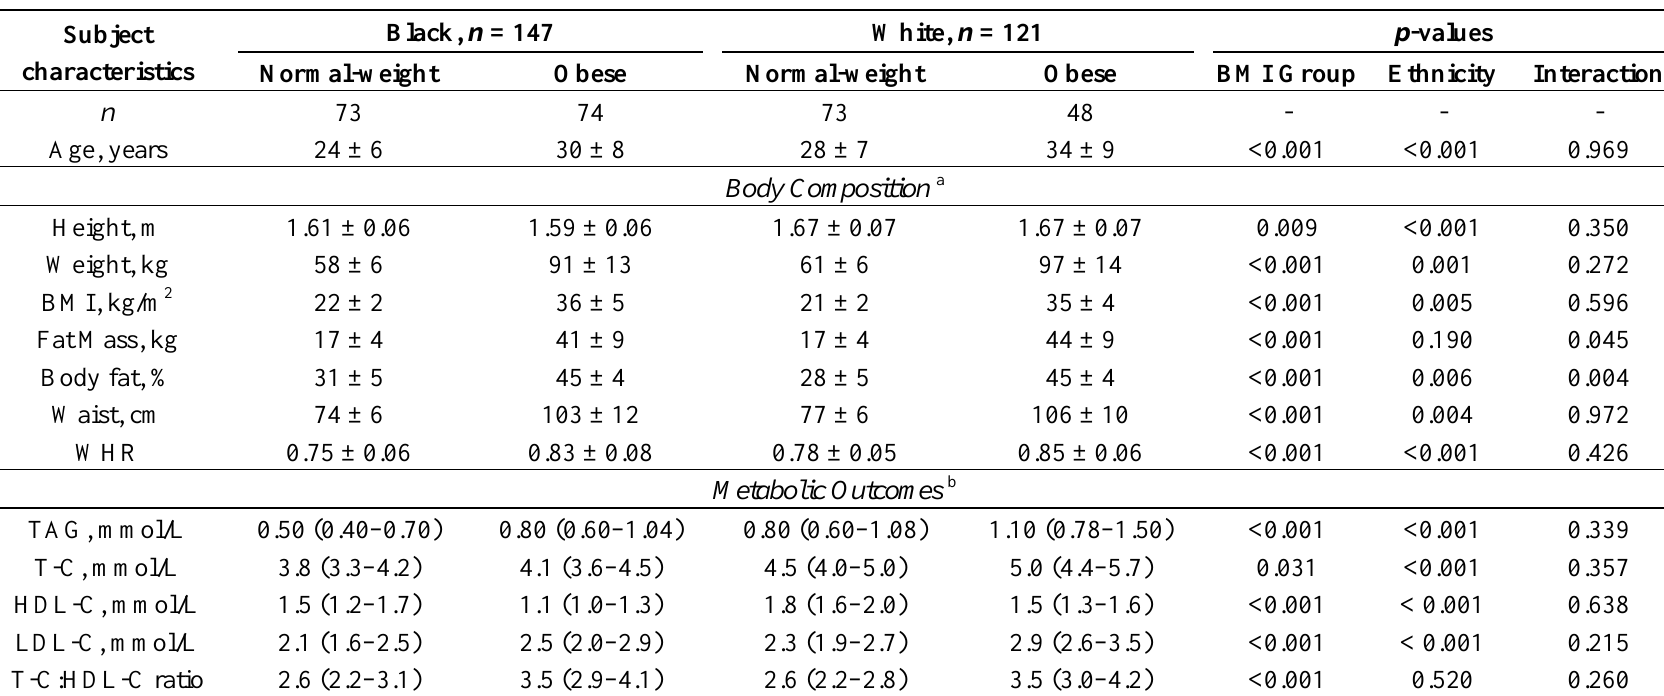
Table 1. Subject characteristics, body composition and serum lipids of normal-weight and obese black and white